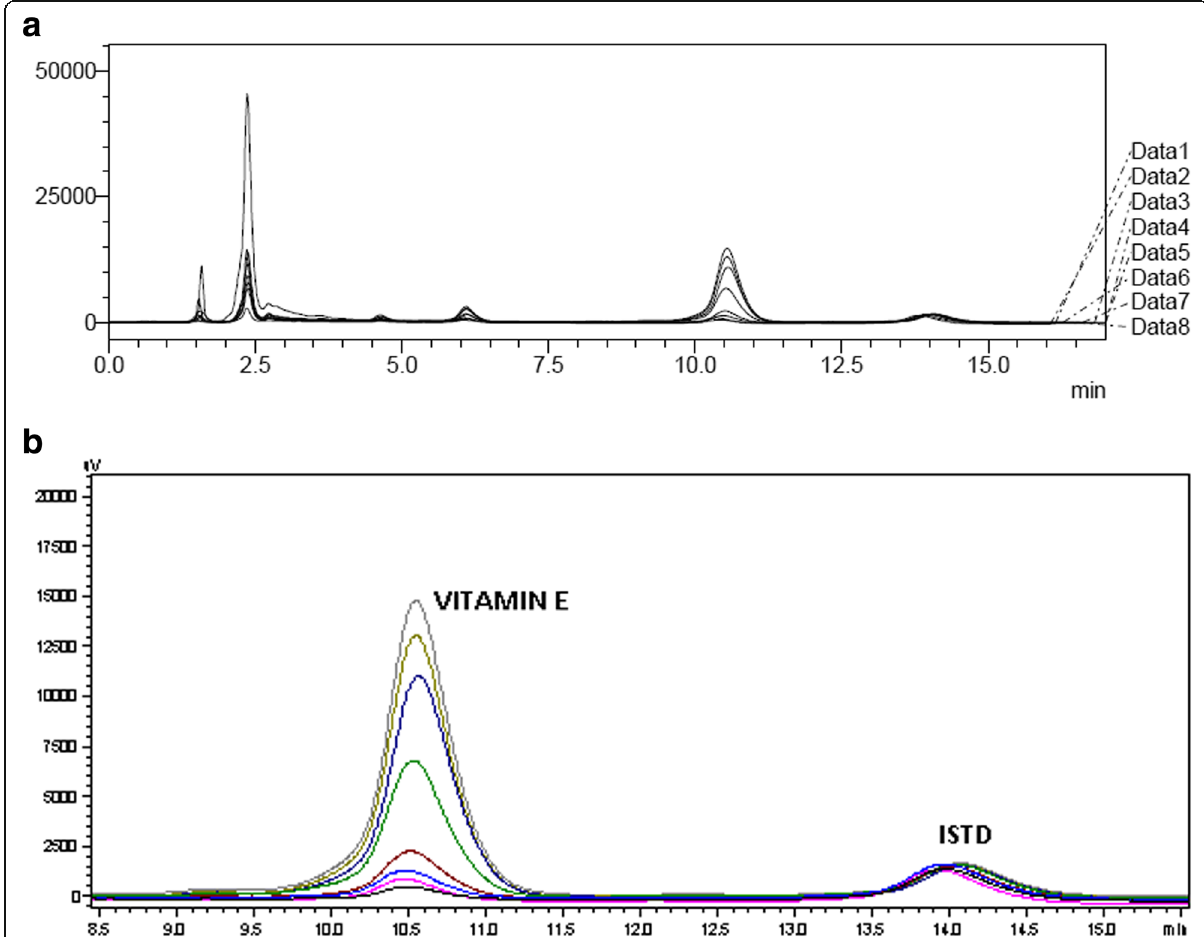
Fig. 5 Overlay spectra of vitamin E and alpha tocopheryl acetate (internal standard) with mobile phase methanol to water (99:1% v/v) (extraction from plasma)